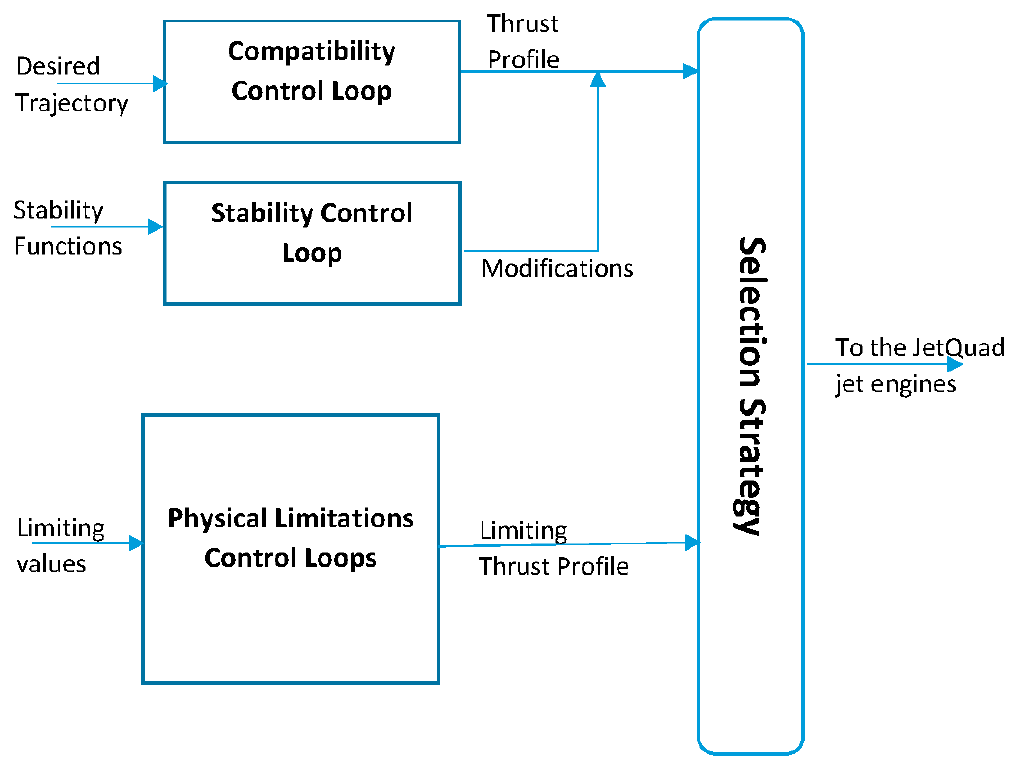
Figure 15. Proposed control structure for the JetQuad.